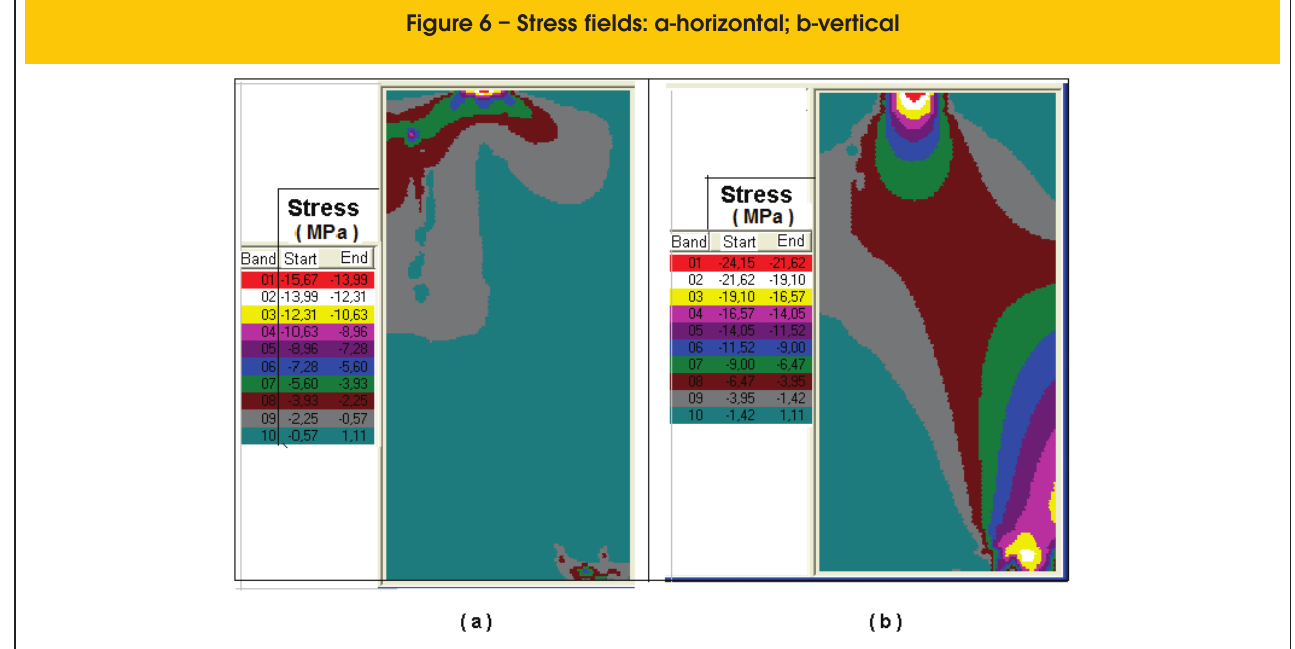
Figure 6 – Stress fields: a-horizontal; b-vertical